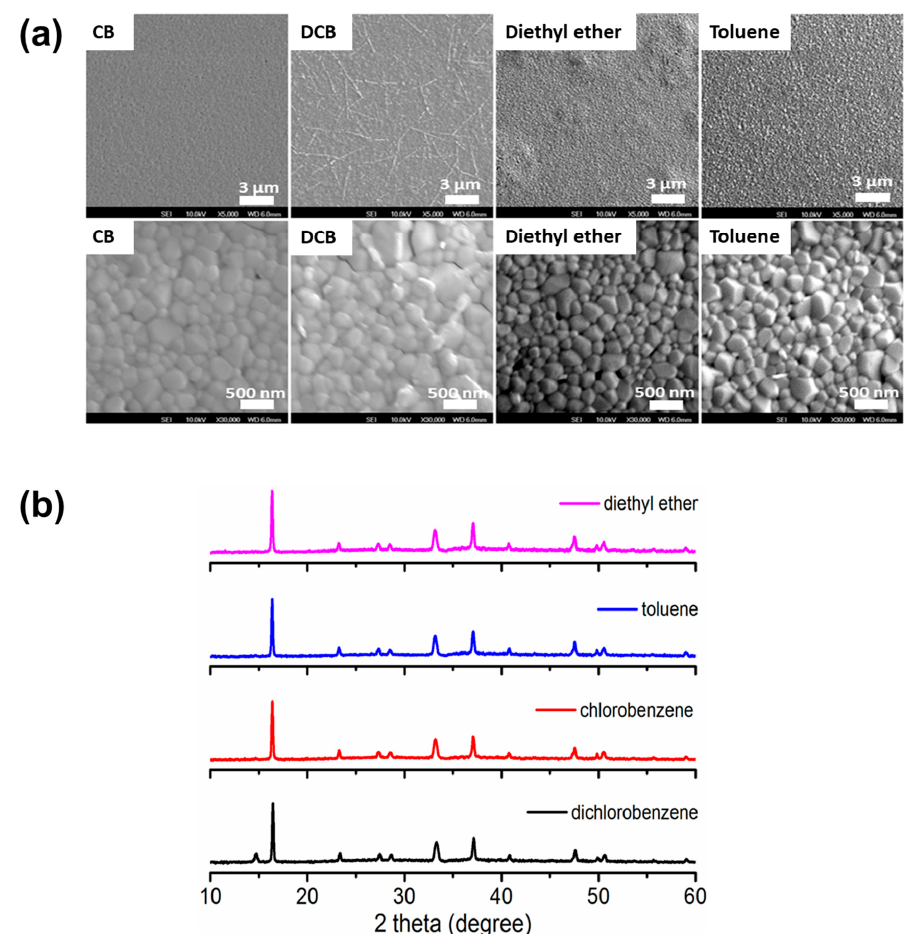
Figure 2. ( a ) SEM images of perovskite-PAMAM (1 wt%) thin films washed by different anti-solvents, including chlorobenzene, dichlorobenzene, diethyl ether, and toluene; ( b ) Corresponding XRD patterns. All films were annealed on a hotplate at 100 °C for 60 min before SEM observations and XRD measurement.